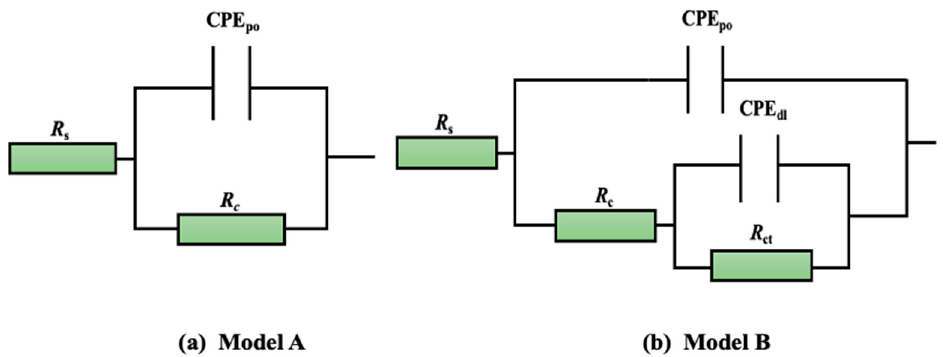
Figure 11. Equivalent electrical models used for EIS data.